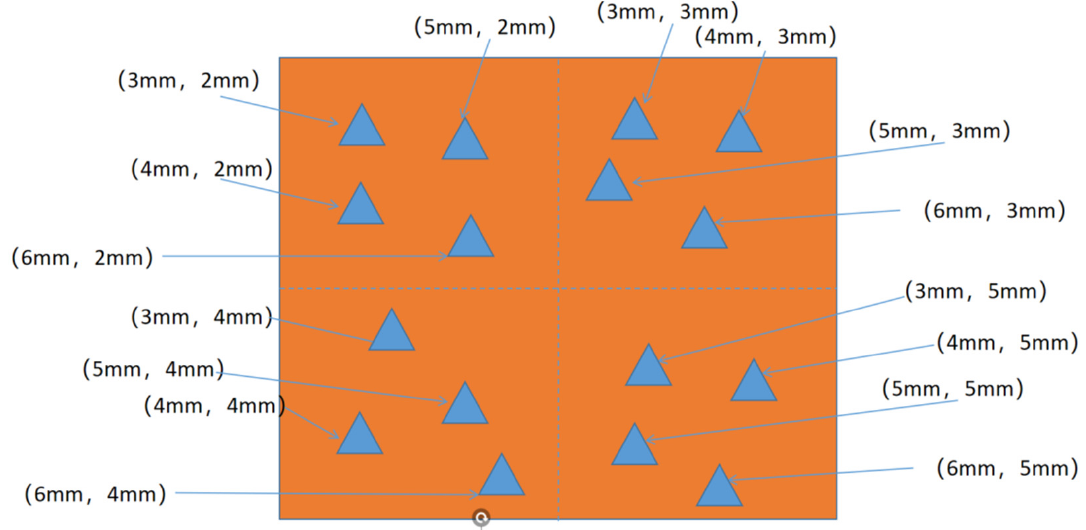
Figure 5. Top view of the defective sample.